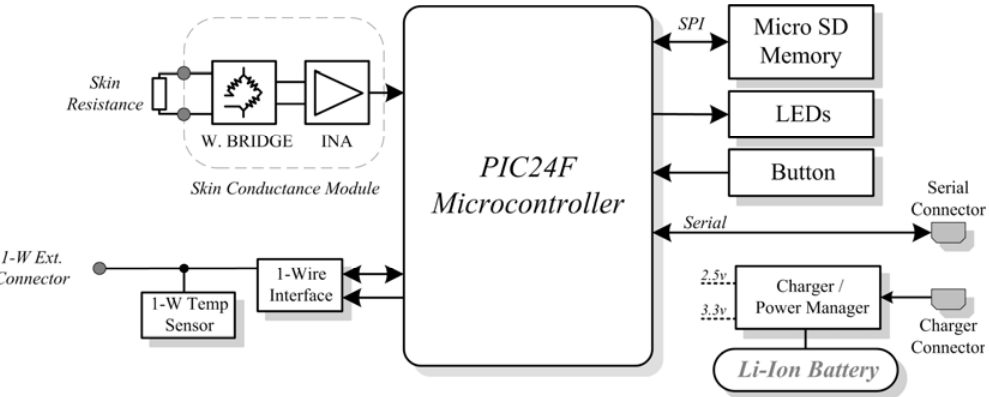
Figure 3. Block diagram of the GSR-Temperature